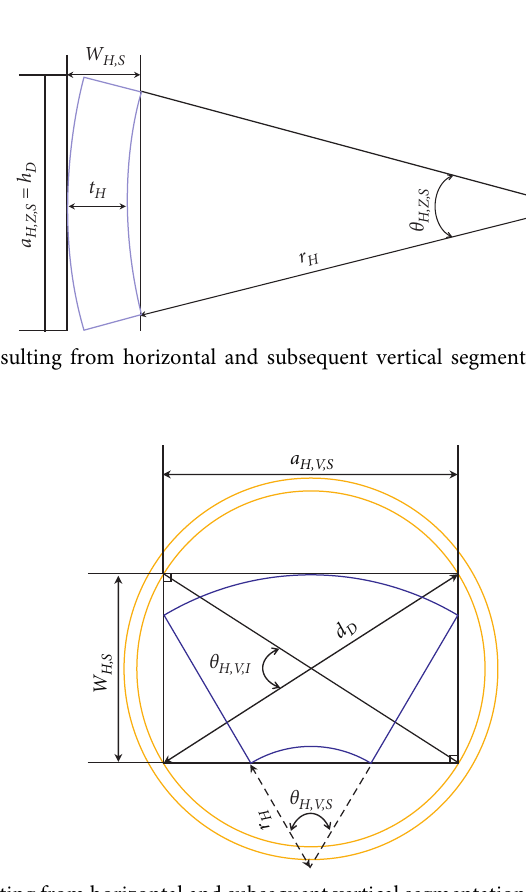
Figure 6: Top view of the piece resulting from horizontal and subsequent vertical segmentations of a hemispherical part of spherocylinder- type object emplaced into a container together with the virtual rectangle assumed in this